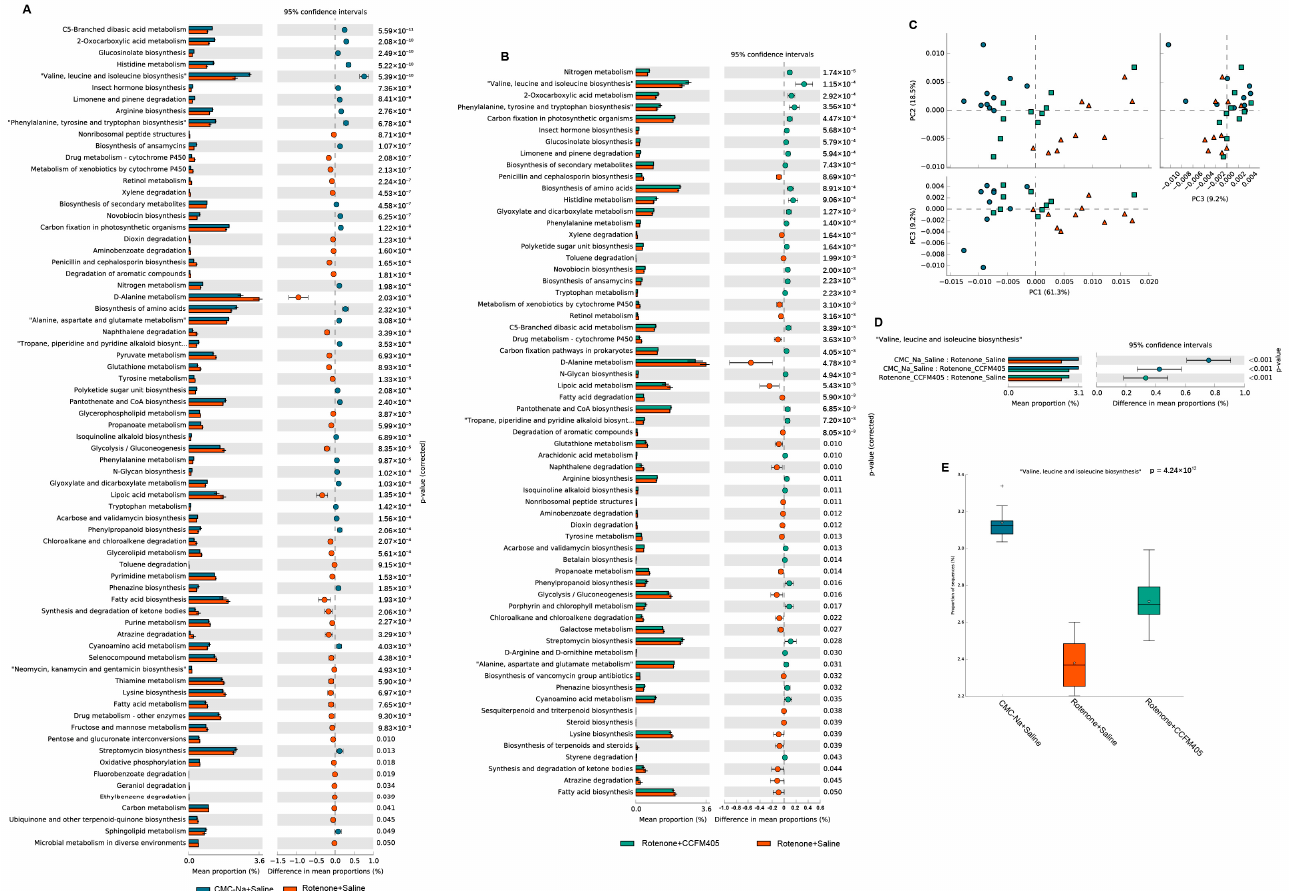
Figure 8. Functional prediction by Phylogenetic Investigation of Communities by Reconstruction of Unobserved States (PICRUSt 2). ( A ) Statistical analysis of difference of Kyoto Encyclopedia of Genes and Genomes (KEGG) pathways between CMC-Na+Saline group and Rotenone+Saline in levels II; ( B ) statistical analysis of difference of KEGG pathways between Rotenone+CCFM405 group and Rotenone+Saline in levels II; ( C ) PCA analysis of KEGG pathways among three groups; ( D , E ) statistical analysis of difference of “Valine, Leucine and isoleucine biosynthesis” pathways, n = 10/group. Growing evidence indicates that the gut microbiota influences the development and function of the brain. The gut–brain connection may be mediated by some microbial molecules produced in the gastrointestinal tract and can subsequently permeate the brain [39]. Therefore, we hypothesized that the potential mechanism of L. plantarum CCFM405 against PD could be related to improved fecal metabolite levels. A non-targeted metabolome based on liquid chromatography–mass spectrometry (LC–MS) was used to investigate the effects of L. plantarum CCFM405 on fecal metabolites. Scanning with LC–MS in positive (POS) and negative ion modes (NEG) identified 1007 and 445 metabolites,